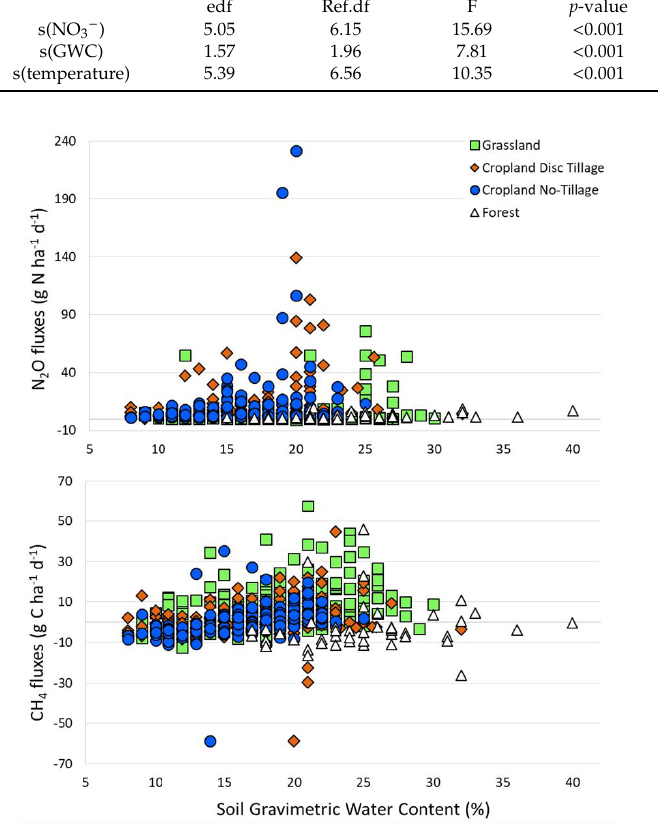
Figure 5. Soil N 2 O and CH 4 fluxes from the three agricultural systems and the forest in relation to soil gravimetric water content at the Combi experimental site (GHG values are means per plot).